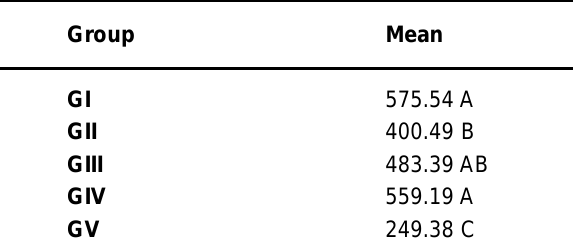
Different letters indicate statistically significant difference (Tukey’s post-hoc test; p<0.05).